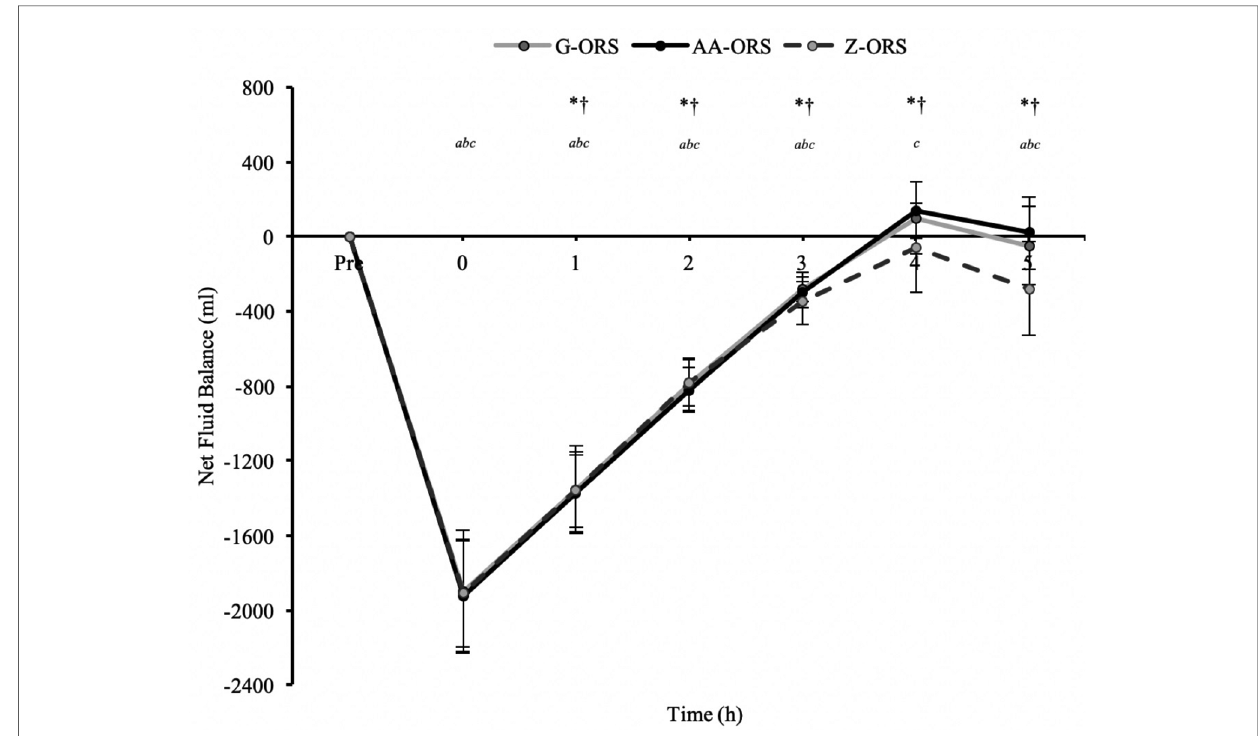
FIGURE 3 Calculated time to reach full recovery of net fl uid balance. *, AA-ORS faster vs. Z-ORS (P <0.05); † , G-ORS faster vs. Z-ORS (P <0.05).